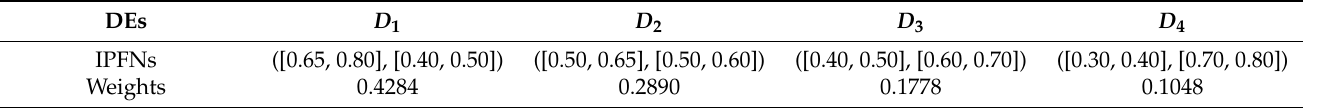
Table 4. Assessment of DEs’ weight.